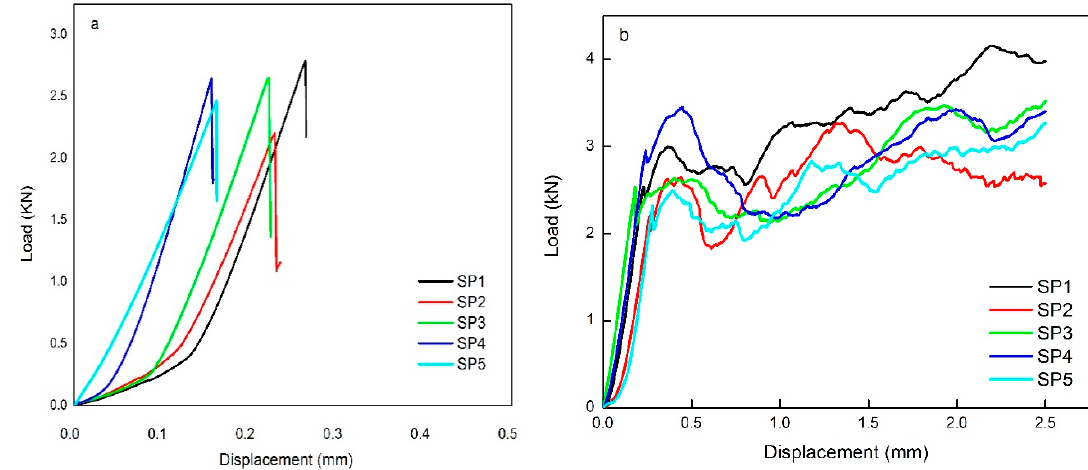
Figure 4. Typical load versus displacement curves obtained by Brazilian tensile strength test of ( a ) unreinforced geopolymer and ( b ) geopolymer composites with 9 vol.% hemp fibers.